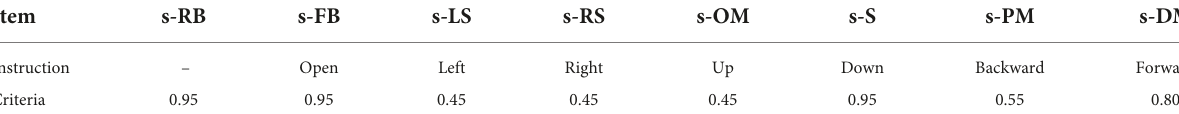
TABLE 16 The operational correspondence, along with the consistency checking criteria x % in Task one.